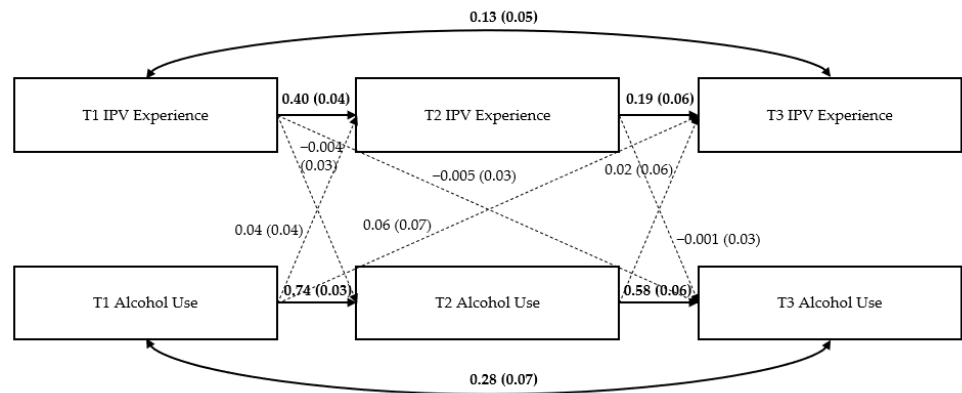
Figure 4. Results of the alcohol use model. Note: Numbers represent standardized path coefficients ( β ) and standard errors (SE) in parentheses. Bolded lines and coefficients are significant; dotted lines